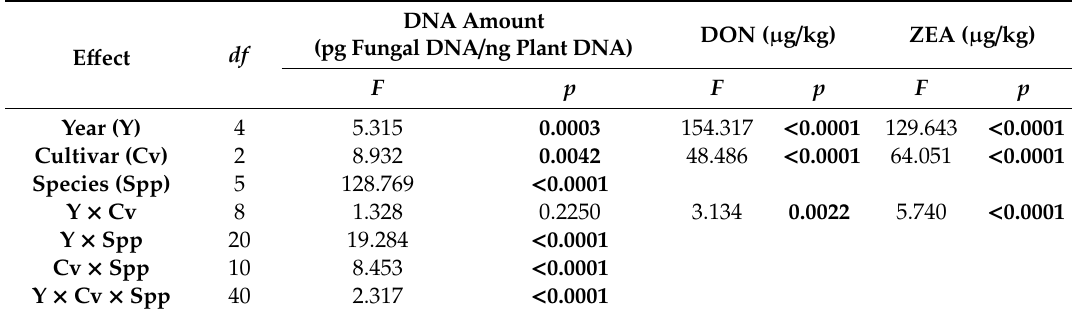
Table 3. ANOVA results for the dependent variables DNA amount (pg fungal DNA / ng plant DNA), DON and ZEA concentration ( µ g / kg) in wheat grain depending on year (Y), cultivar (Cv), species (Spp; only DNA amount) and their interactions summarized for all survey years (2013–2017), cultivars (highly, moderately to highly and lowly to moderately susceptible) and detected Fusarium species ( F. graminearum , F. culmorum , F. avenaceum , F. poae , F. tricinctum , F. langsethiae ) of the seven trial locations (three replications per location) in northern Germany. n = 315. DNA Amount DON ( µ g / kg) (pg Fungal DNA / ng Plant DNA) E ff ect